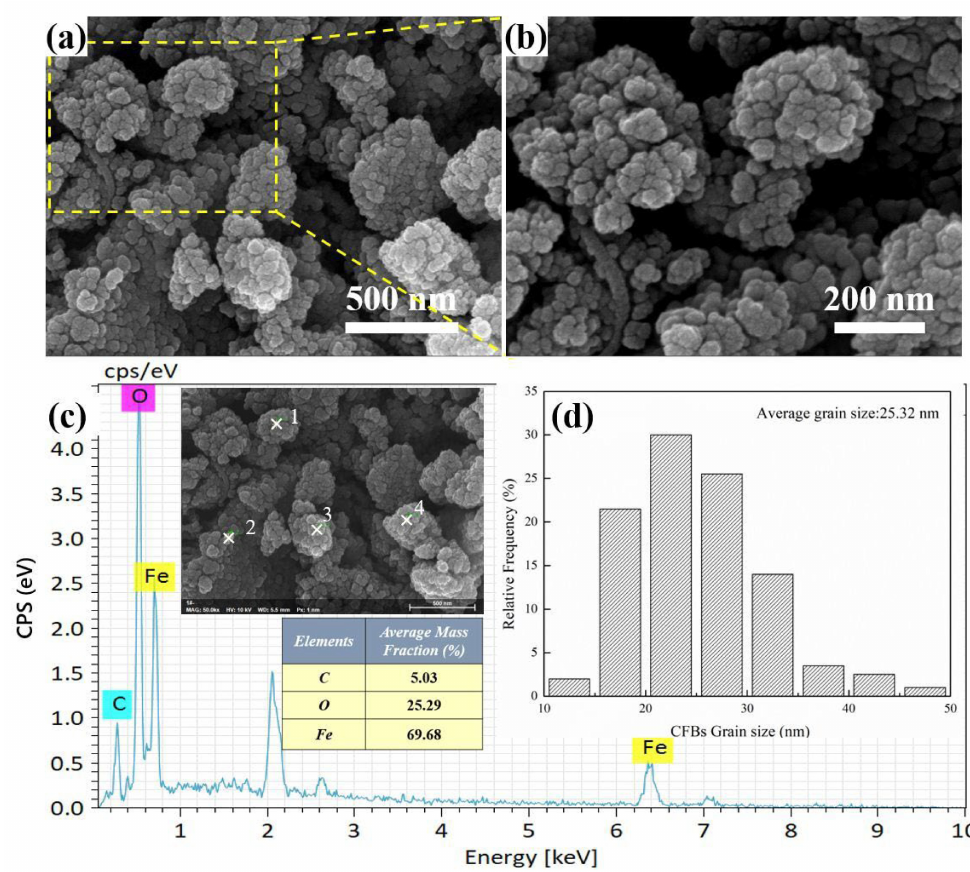
Figure 3. ( a , b ) SEM images of CFBs, ( c ) EDS spectrum of CFBs, ( d ) particle size distribution of